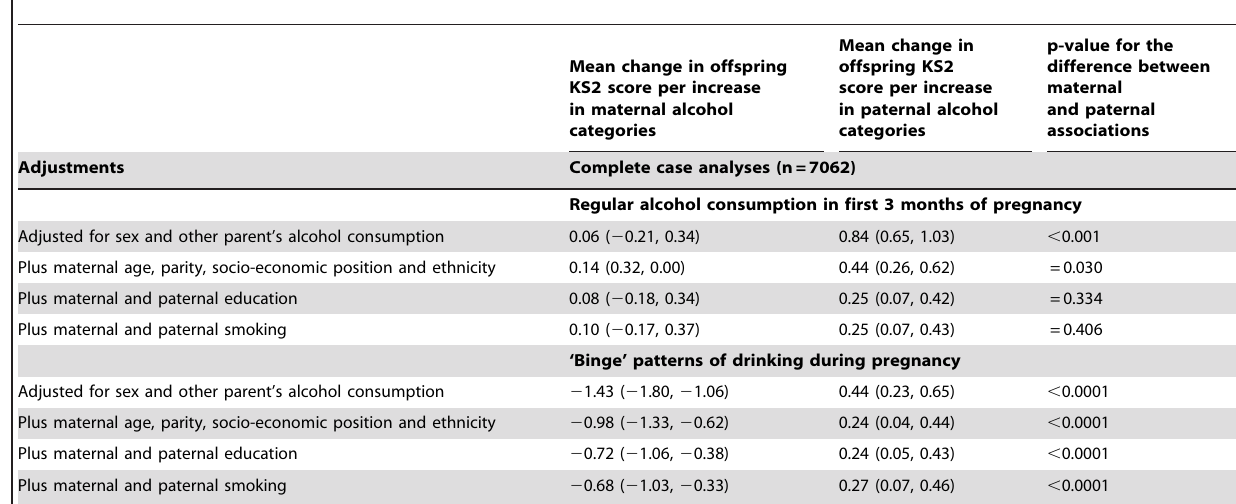
Table 4. Mean change in offspring KS2 score per increase in maternal and paternal alcohol